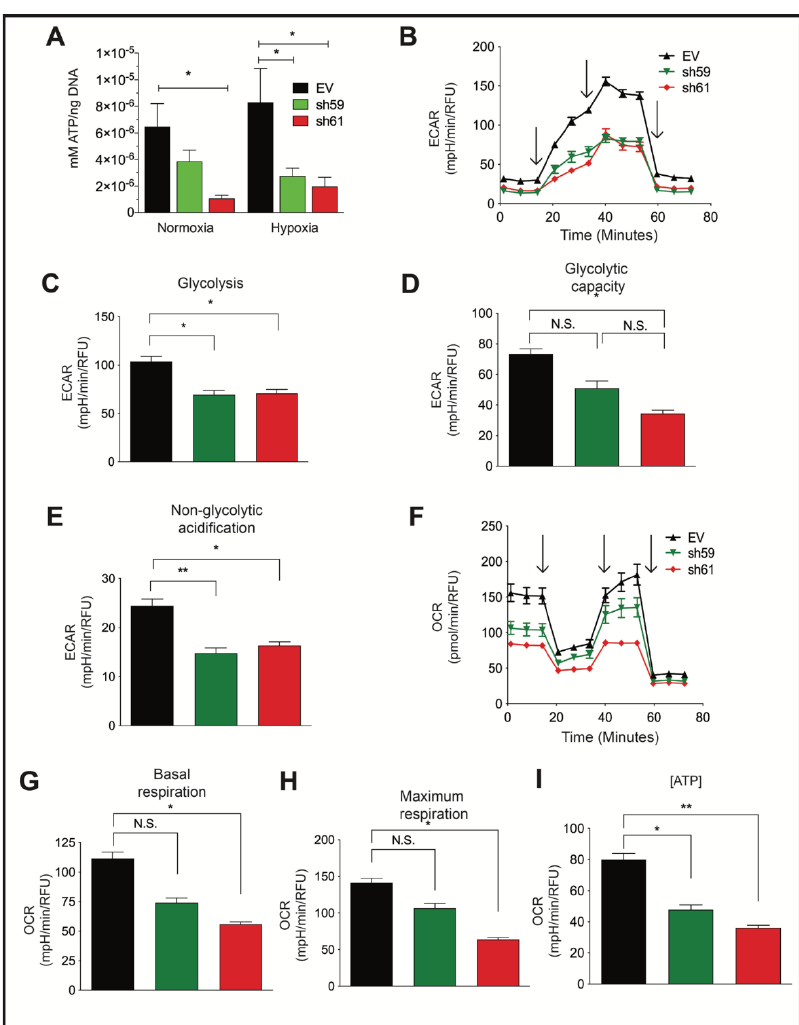
Figure 3. Ckb knockdown in PyMT cells reduces ATP levels and impairs both glycolysis and mitochondrial respiration. ( A ) PyMT EV, sh59 and sh61 cells were plated in triplicate and grown to 80% confluence prior to normoxic or hypoxic culture (24 h). Cells were harvested, washed with ice-cold PBS, and immediately lysed on the plate for comparison of the intracellular ATP levels by a bioluminescent assay, and data were normalized to total DNA content. The mean ATP concentration (mM) per ng of DNA ± SEM is shown ( n = 3 technical replicates per cell line/oxygen tension). The data shown are representative of three independent biological replicates. ( B – I ) PyMT EV, sh59 Ckb KD, and sh61 Ckb KD cells were profiled for metabolic activity using Seahorse bioanalyzer assays (Glycolysis Stress or Mito Stress test kits) to measure changes in parameters associated with either ECAR, panels ( B – E ), or with mitochondrial respiration (OCR, panels ( F – I )). The black arrows ( B , F ) indicate when injections occurred during the assays. Changes were observed in ECAR plotted over time ( B ), peak glycolysis ( C ), glycolytic capacity ( D ), non-glycolytic acidification ( E ), OCR over time ( F ), basal respiration ( G ), maximum respiration ( H ), and ATP-linked respiration ( I ) in sh61 Ckb KD cells. For some of the measured outputs, there were also significant changes observed in sh59 Ckb KD cells. Panels ( B , F ) are representative of three independent experiments. For panels ( C – E , G – I ), the bar graphs represent the overall mean of three independent experiment means across n = 6 technical well replicates/genotype/experiment. Each genotype of cells was randomly plated in different patterns during each independent experiment to minimize any potential effects of plate well location on